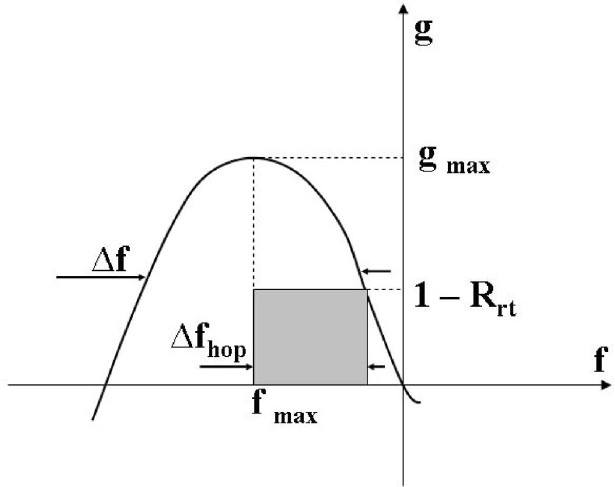
FIG. 9. Frequency shift (cid:1) f is the range in which the lasing hop is retained. Beyond this limit the laser condition g > 1 – R rt would hop to lase at a different resonator mode or cease lasing altogether. This range is longer the higher is the gain and the . The optimal value of 1 – R maximizing lower is the factor 1 – R rt rt corresponds to a state of maximal area of the shaded (cid:1) f sweep rectangle.